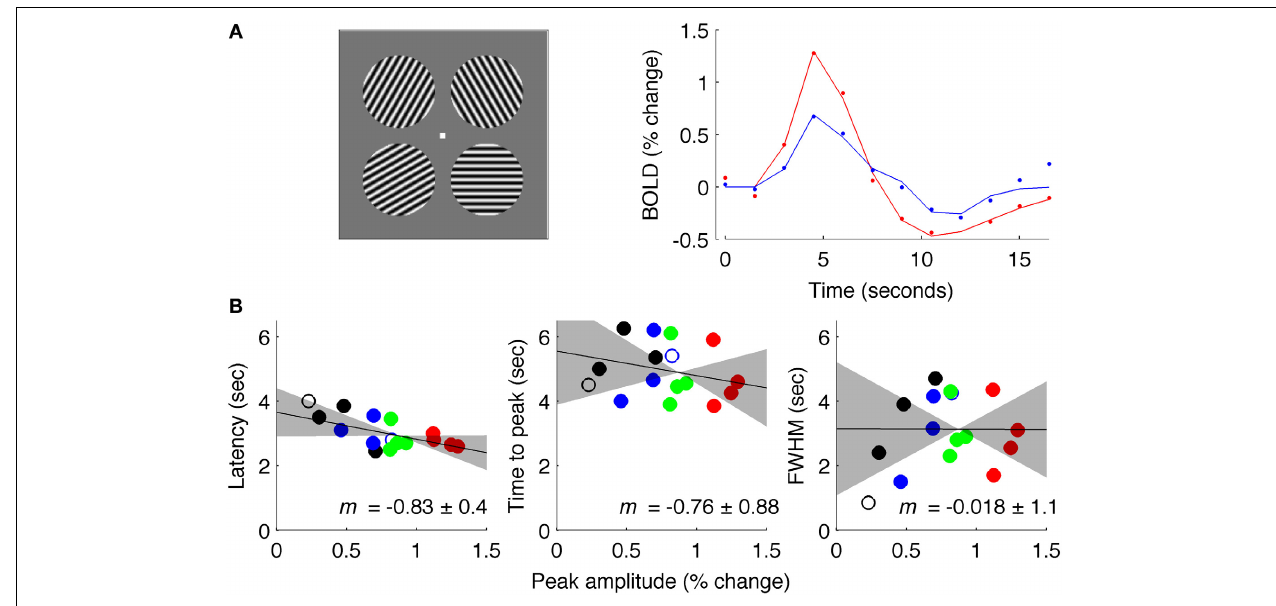
FIGURE 7 | Results of Experiment 3: intermediate ISI. (A) Left: stimuli used for experiment at 7 Tesla. Right: estimated fMRI response for 18s after stimulus onset for representative subject, with solid lines showing fit of